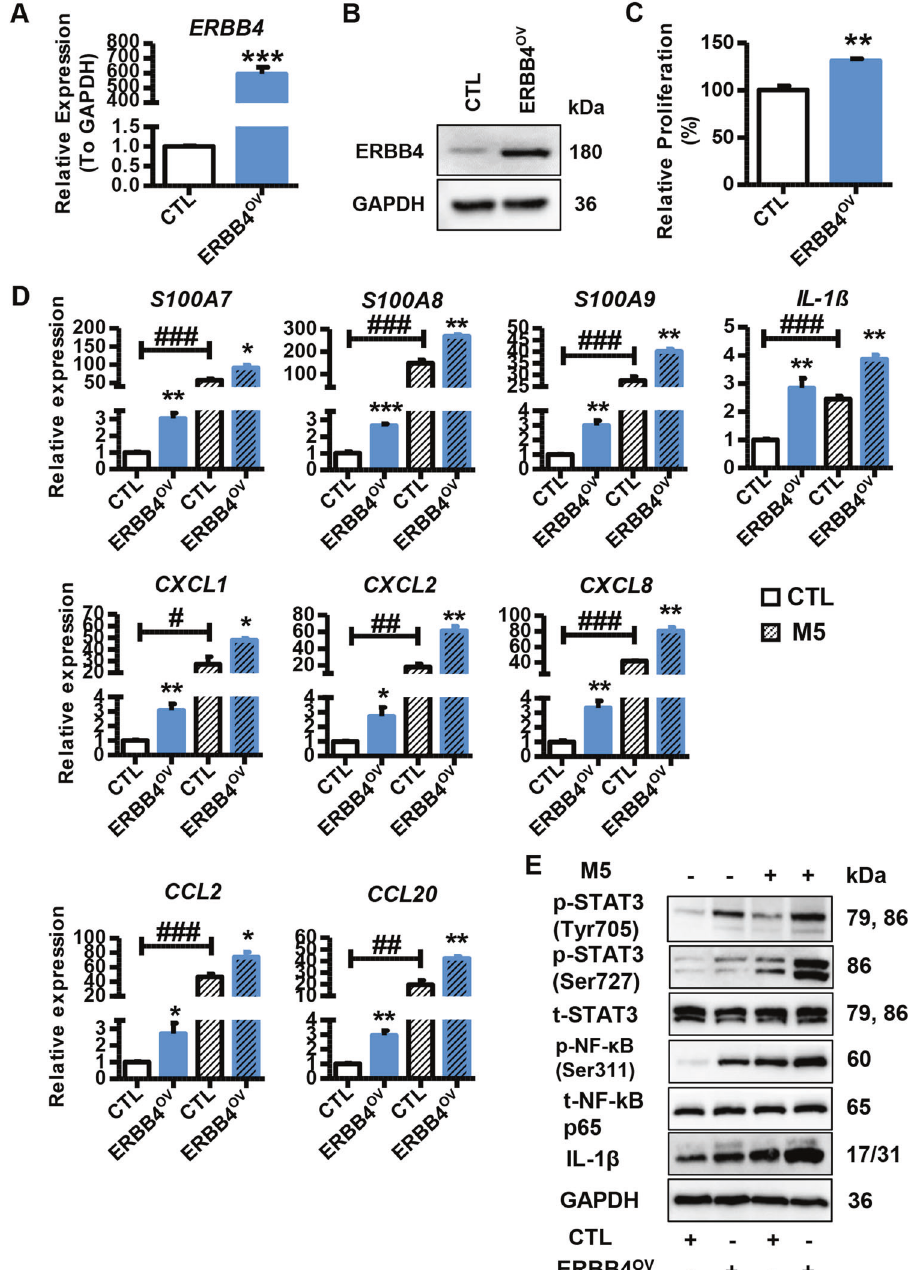
Fig. 7 Function of ERBB4 overexpression in keratinocytes. A Expression levels of ERBB4 in HaCaT cells transfected with ERBB4- overexpression vector (ERBB4 OV ) or indicated control (CTL). Cells were collected 2 days after transfection and mRNA levels were analyzed using qRT-PCR. GAPDH was used as the internal control. Each bar represents mean ± SEM ( n = 3). *** P < 0.001, compared with the indicated controls. B Representative blots showing protein levels of ERBB4 in HaCaT cells transfected with ERBB4 OV or CTL. Protein levels were detected by western blotting. GAPDH was used as a protein loading control. C Relative proliferation rate of HaCaT cells transfected with ERBB4 OV or CTL. Cell proliferation was analyzed using MTT assay. Each bar represents mean ± SEM ( n = 3). ** P < 0.01, compared with the indicated controls. D The mRNA levels of psoriasis-related genes and in fl ammatory genes in HaCaT cells transfected with ERBB4 OV or CTL in the presence or absence of M5 treatment. Cells were harvested 2 days after transfection and mRNA levels were analyzed using qRT-PCR. GAPDH was used as the internal control. Each bar represents mean ± SEM ( n = 3). ** P < 0.01, * P < 0.05, ### P < 0.001, ## P < 0.01, # P < 0.05, compared with the indicated controls. E Representative blots showing the levels of phospho-STAT3 (Tyr705), phospho-STAT3 (Ser727), phospho-NF- κ B p65 (Ser311), and IL- 1 β in the HaCaT cells transfected with ERBB4 OV or CTL in the presence or absence of M5 treatment. Protein levels were detected by western blotting. GAPDH was used as a protein loading